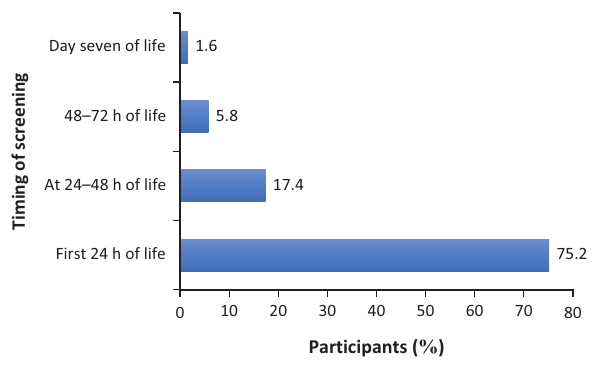
FIGURE 1: Time when hearing screening occurred in the current sample ( N =